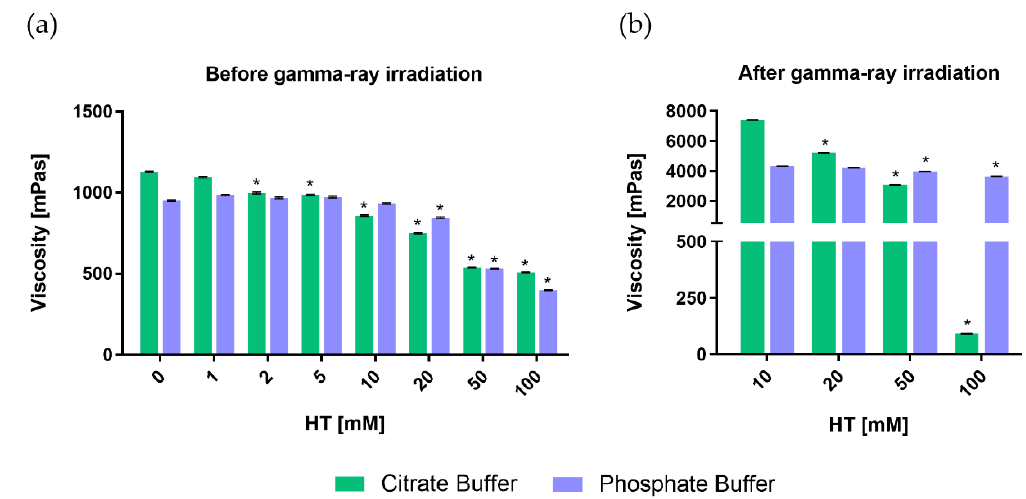
Figure 1. ( a ) Change in the viscosity of non-irradiated polyethylene oxide (PEO) 4% hydrogels when increasing hydroxy- tyrosol (HT) concentration; * p < 1 × 10 −4 vs. HT 0 mM samples in the corresponding buffer; ( b ) Change in the viscosity of PEO 4% hydrogels when increasing HT concentration after gamma ray irradiation; * p < 1 × 10 −4 vs. HT 10 mM samples in the corresponding buffer.